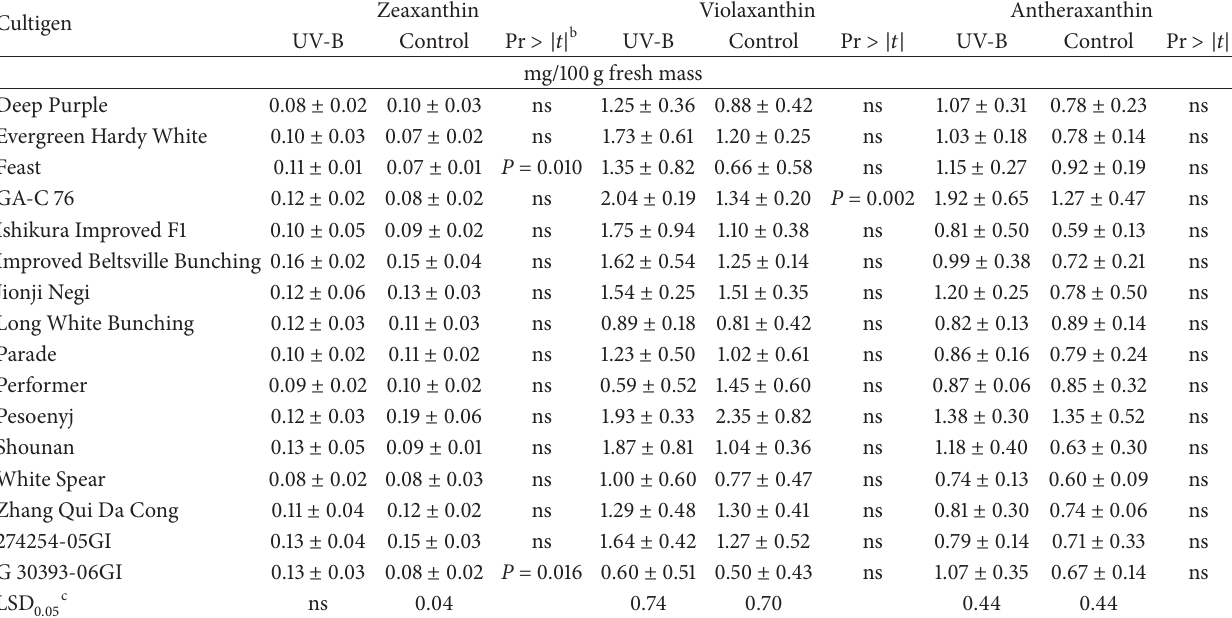
Table 2: Mean values a for shoot tissue zeaxanthin, violaxanthin, and antheraxanthin (mg/100g fresh mass) for Allium fistulosum L.